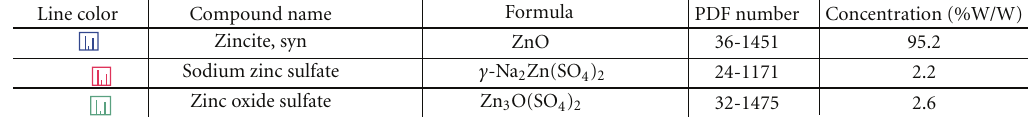
Figure 4: The XRD micrograph of synthesized ZnO nanoparticles.